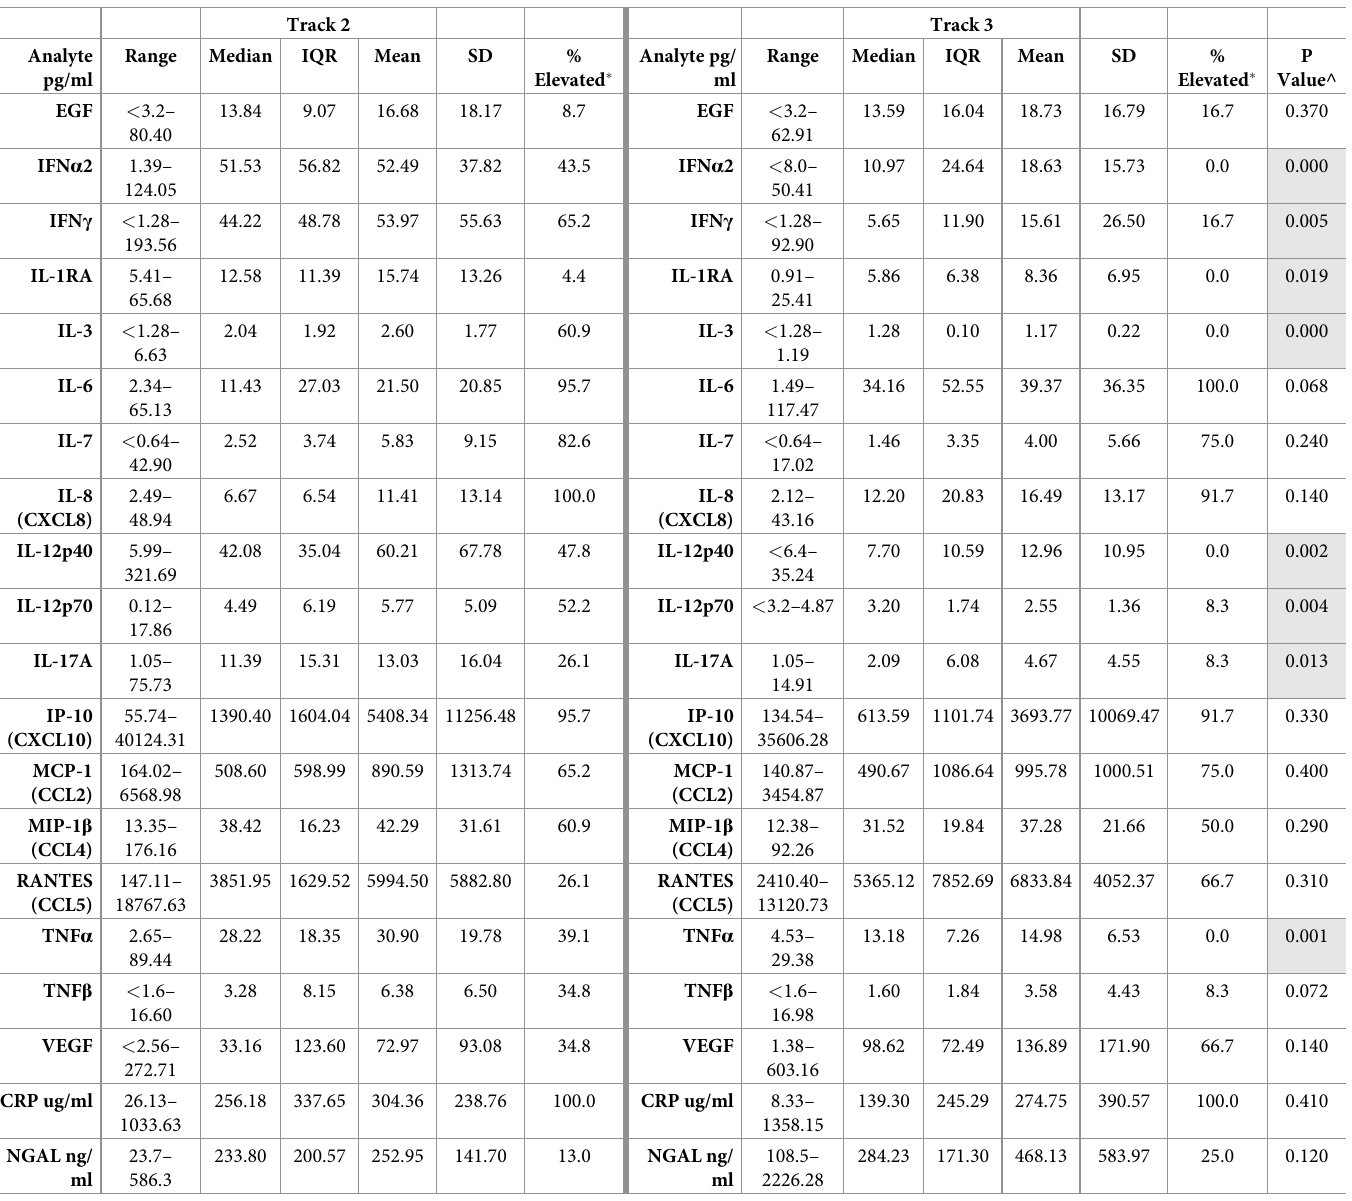
Table 4. Summary of Pre-Infusion Recipient Cytokine Levels of